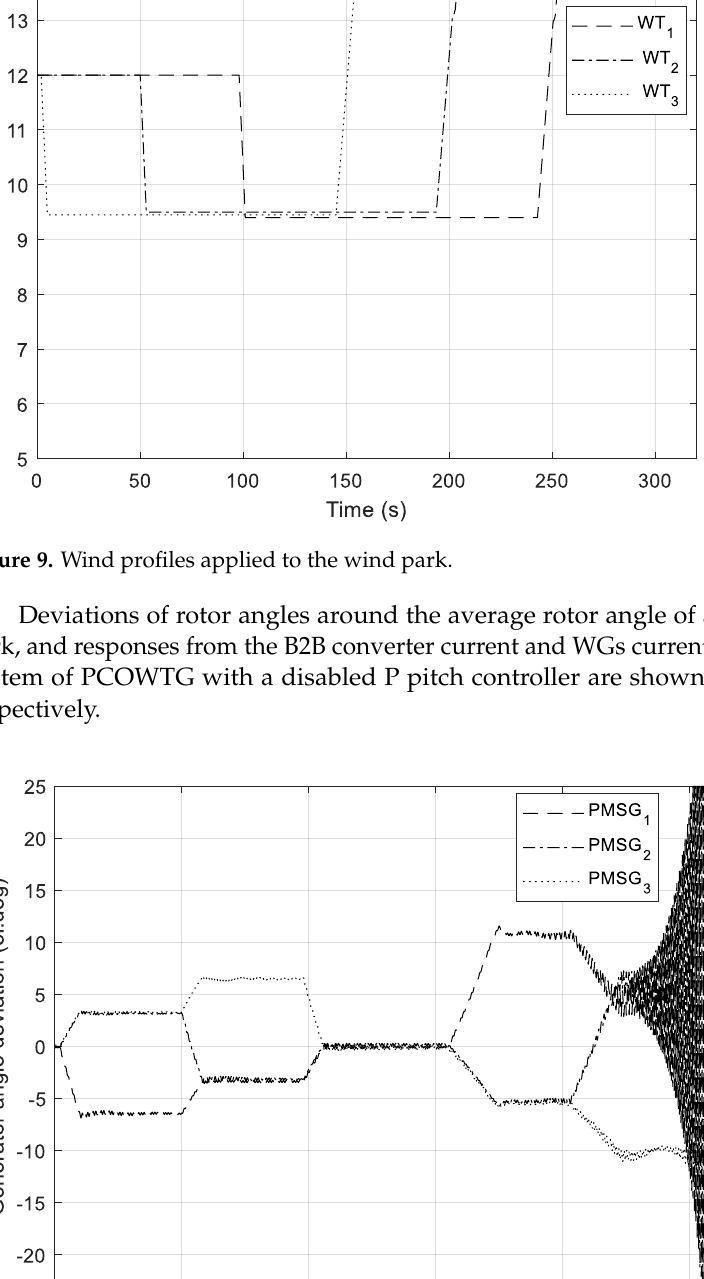
Figure 10. Deviations of rotor angles for control system with disabled P pitch controller.